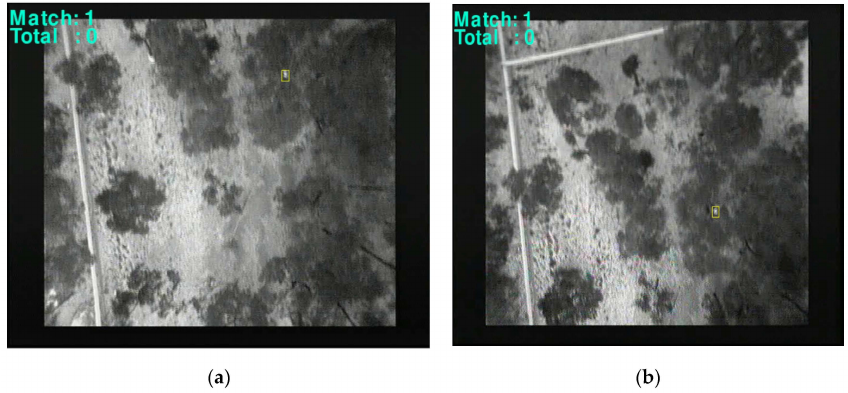
Figure 17. Koala tracking and detection above the canopy at 60 m.